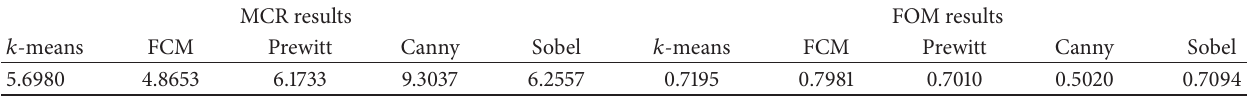
Table 1: MCR and FOM results for the manually ground truth edge in Figure 8(a).